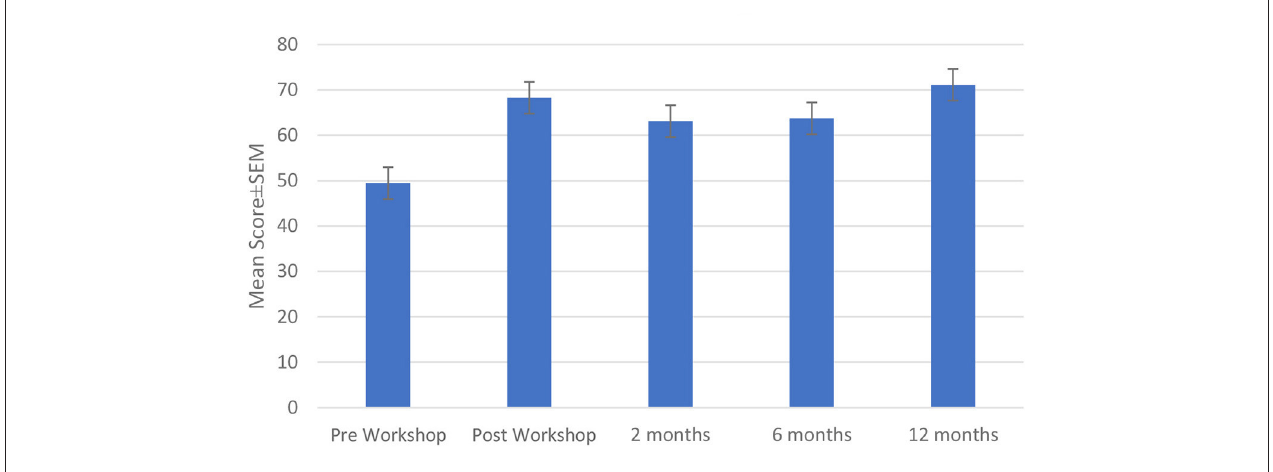
FIGURE 3 | Mean self-esteem rating